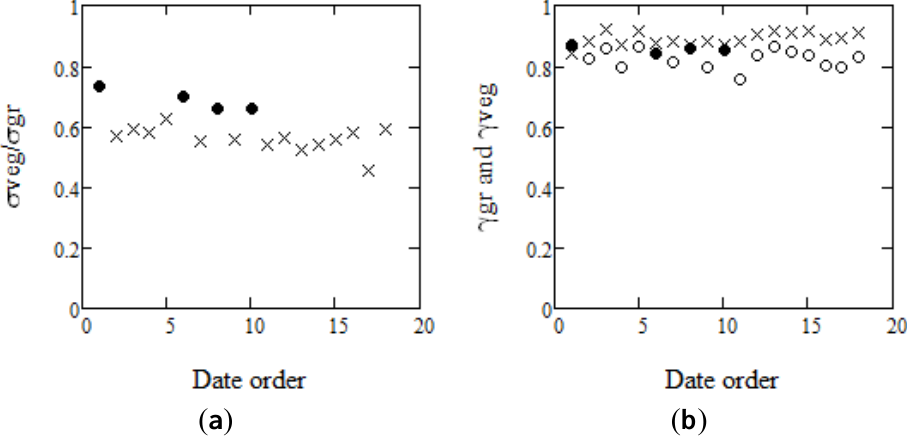
Figure 6. ( a ) Estimates of (cid:2026) (cid:3049)(cid:3032)(cid:3034)(cid:3042) /(cid:2026) (cid:3034)(cid:3045)(cid:3042) ( cf . Equation (5)) (  and  for incidence angles of 34° and 41°, respectively) and ( b ) estimates of  |HOA|  80 m or above, respectively) versus TDM acquisition date (date order).